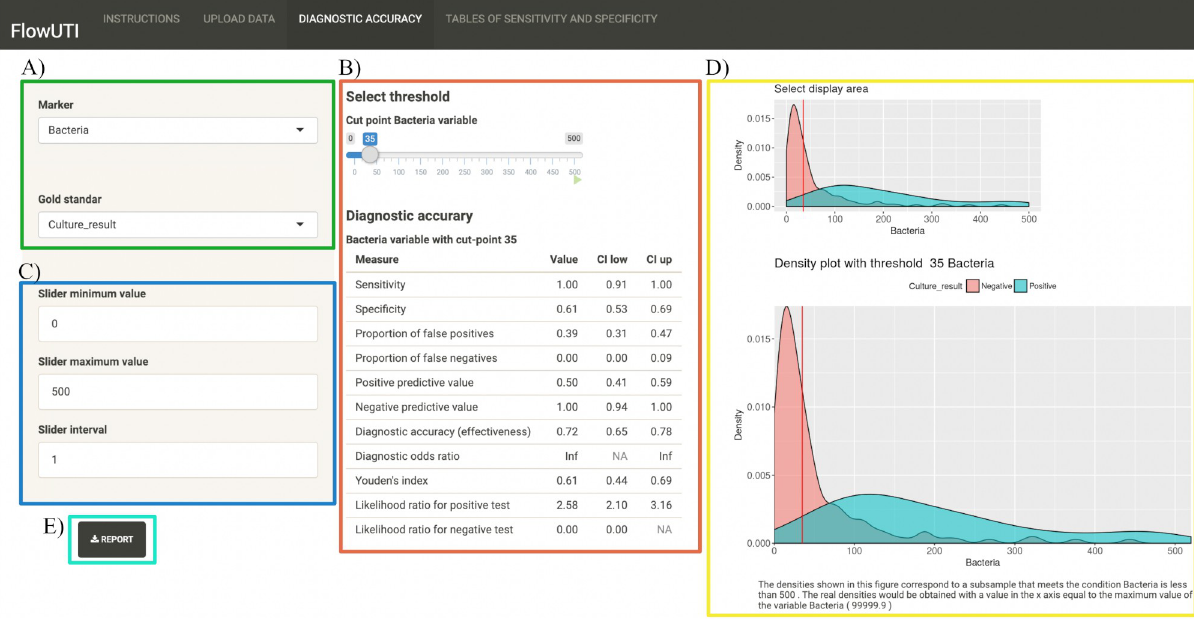
PLOS ONE | https://doi.org/10.1371/journal.pone.0277340 November8,